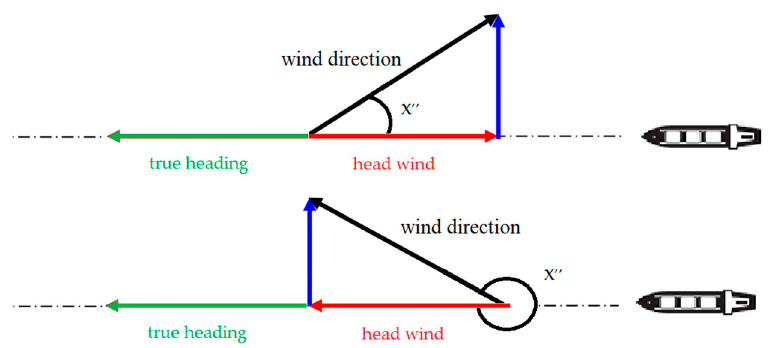
Figure 2. Schematic presentation of HWS